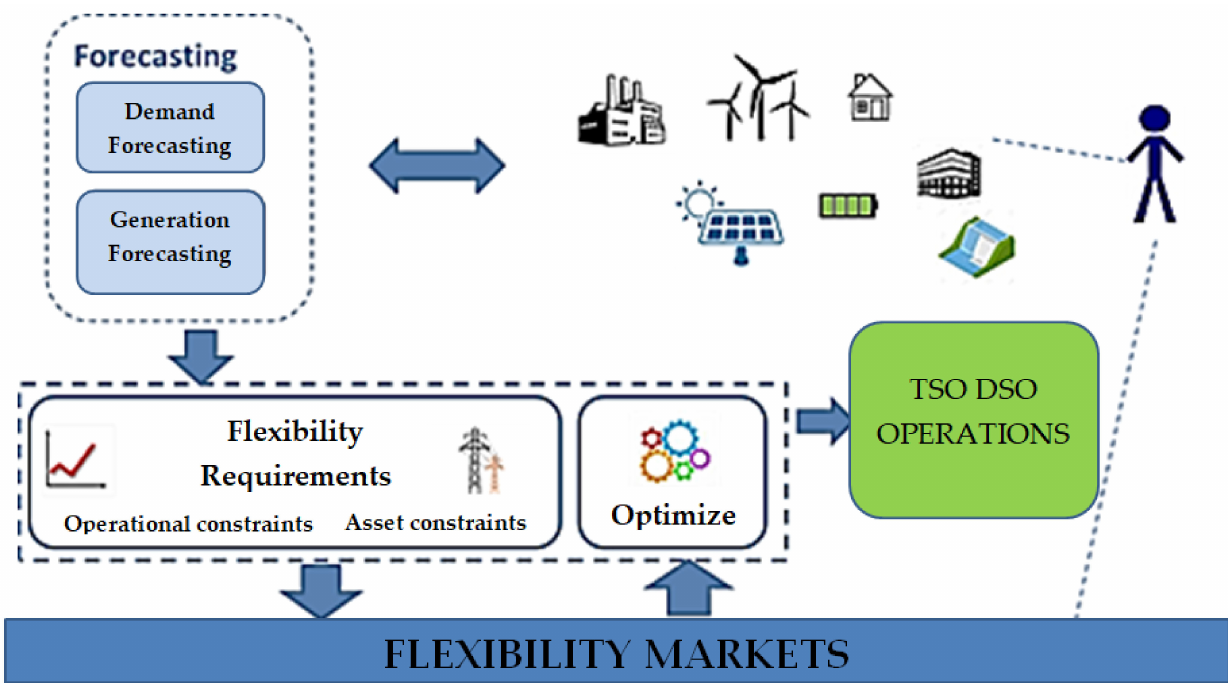
Figure 4. F-channel